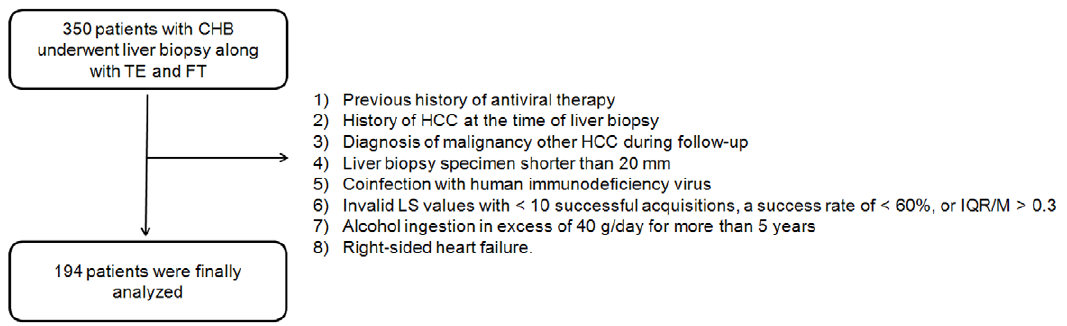
Figure 1. Flow chart describing the selection of the study population. Based on the exclusion criteria, 194 subjects were finally recruited for analyses.